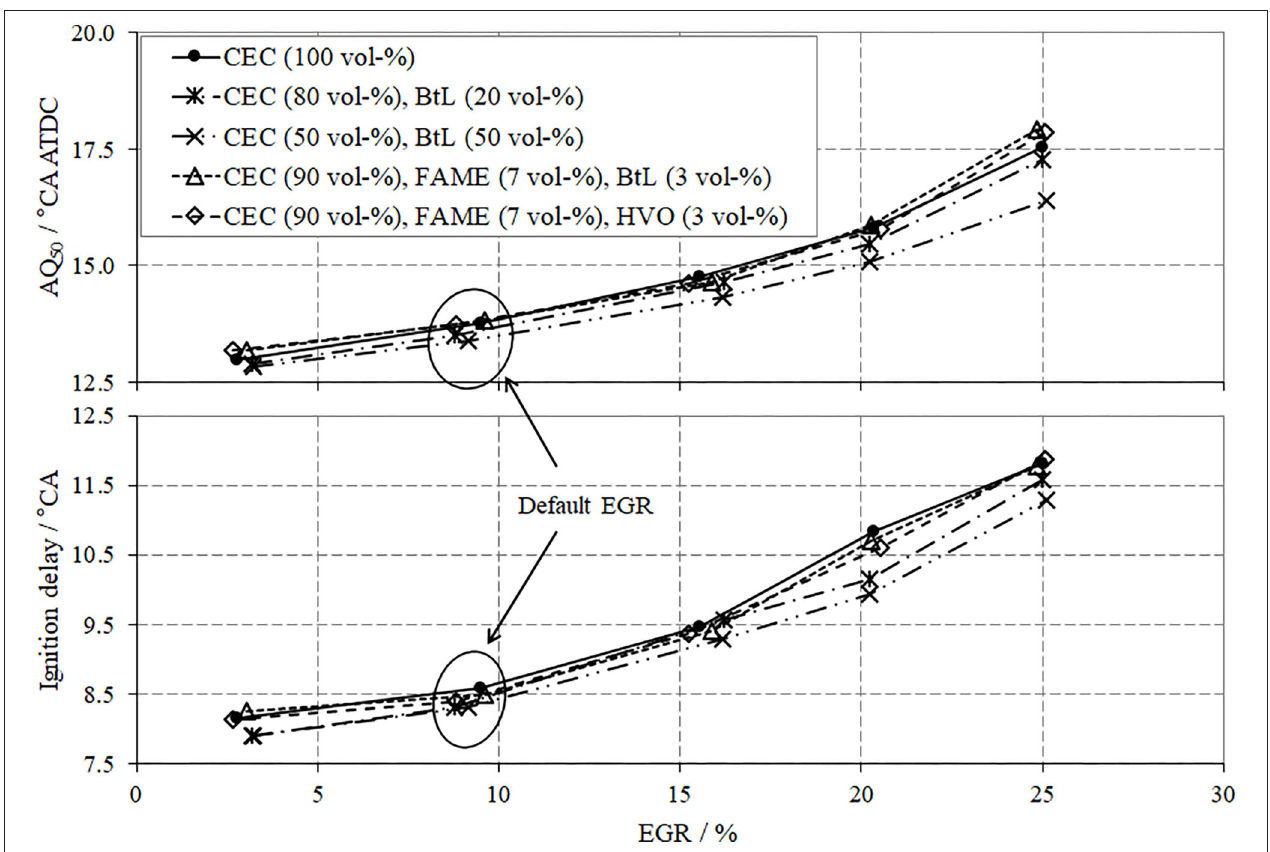
FIGURE 7 | AQ 50 and IGD at 1,500 min − 1 and 5 bar BMEP with varying